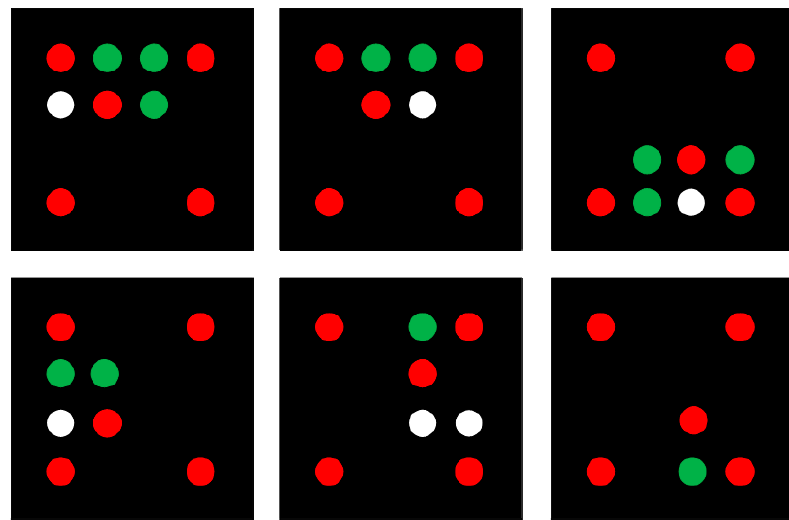
Figure 2. Examples of color scatter-encoded target patterns.